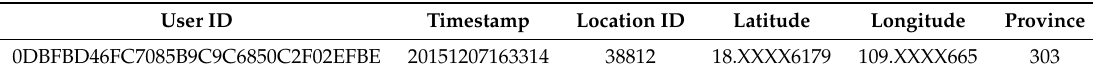
Table 2. Data format of Call Detail Records